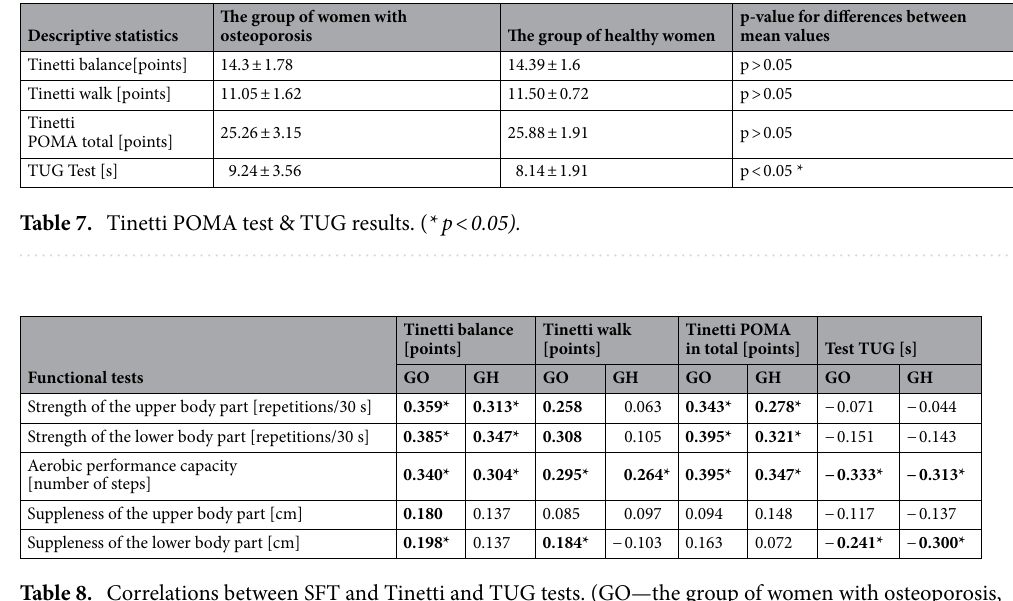
Table 8. Correlations between SFT and Tinetti and TUG tests. (GO—the group of women with osteoporosis, GH—the group of healthy women; * p < 0.05).